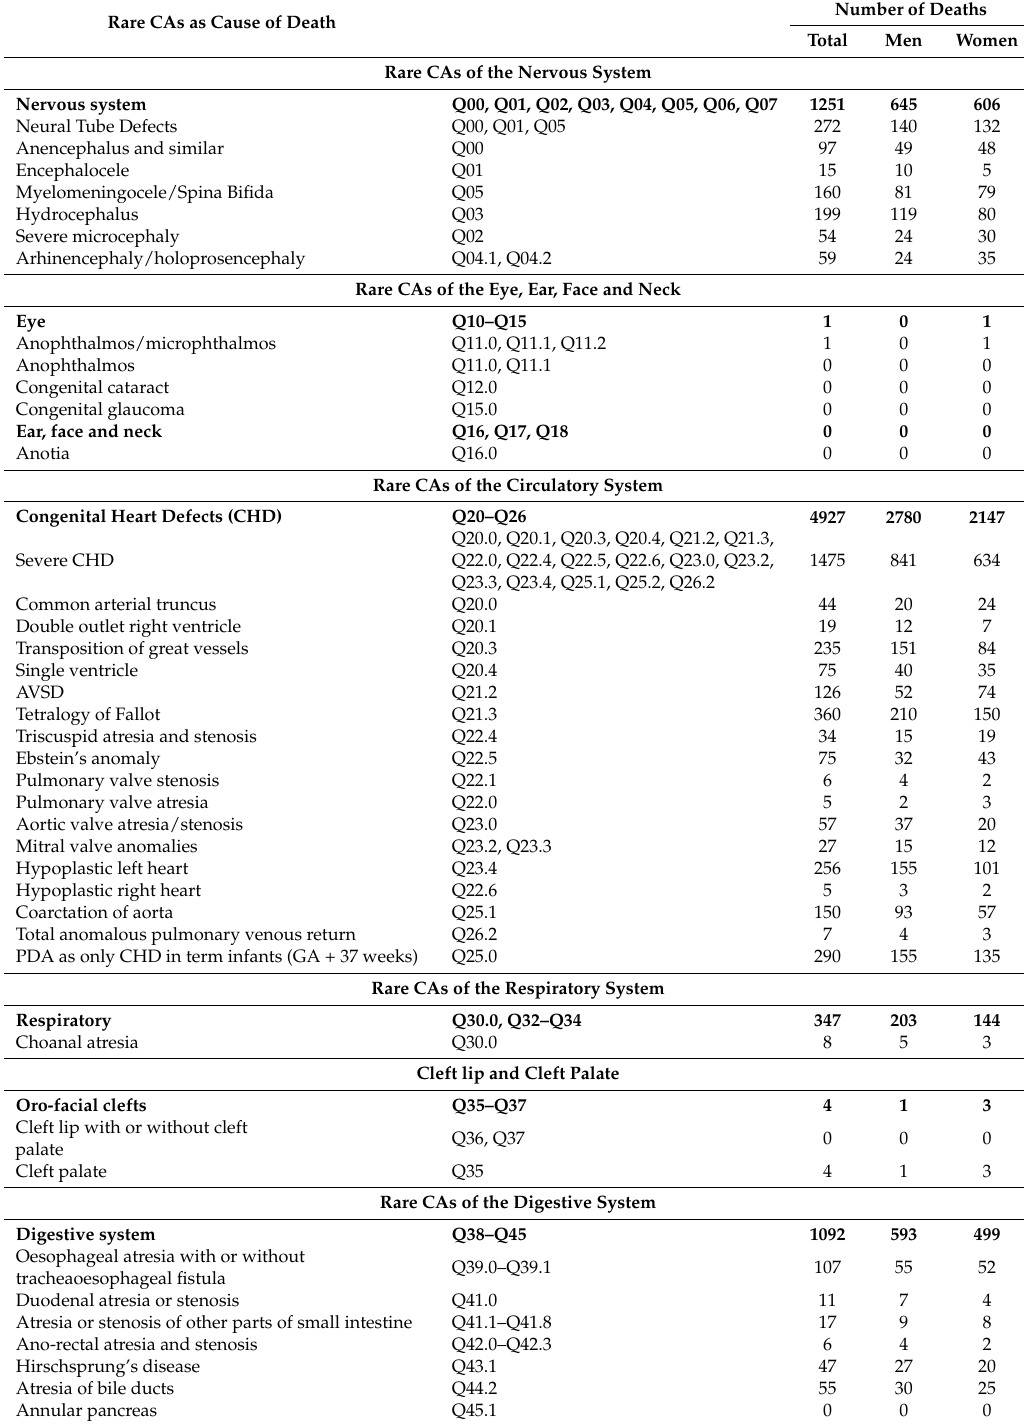
Table 1. Number of deaths registered in Spain (1999–2013) by underlying cause of death, this being a rare CA. The following list of rare congenital anomalies is based on EUROCAT subgroups of congenital anomalies [4]. Only those EUROCAT defects considered as rare diseases with corresponding ICD-10 codes are